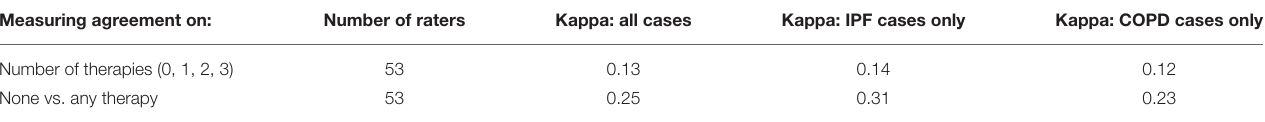
TABLE 4 | Fleiss’ Kappa calculations for respondents who identified as pulmonologists and completed the entire survey ( n = 53).